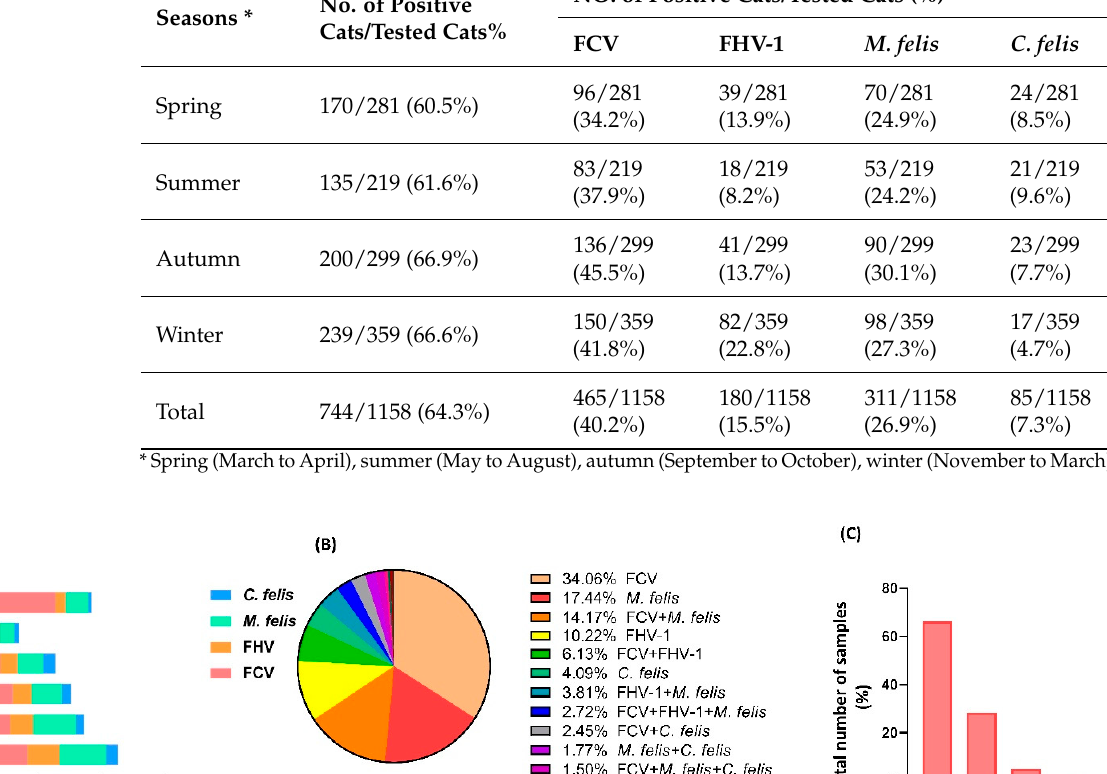
Table 2. Total positive rates of FCV, FHV-1, M. felis and C. felis with upper respiratory tract infection in Wuhan, China.